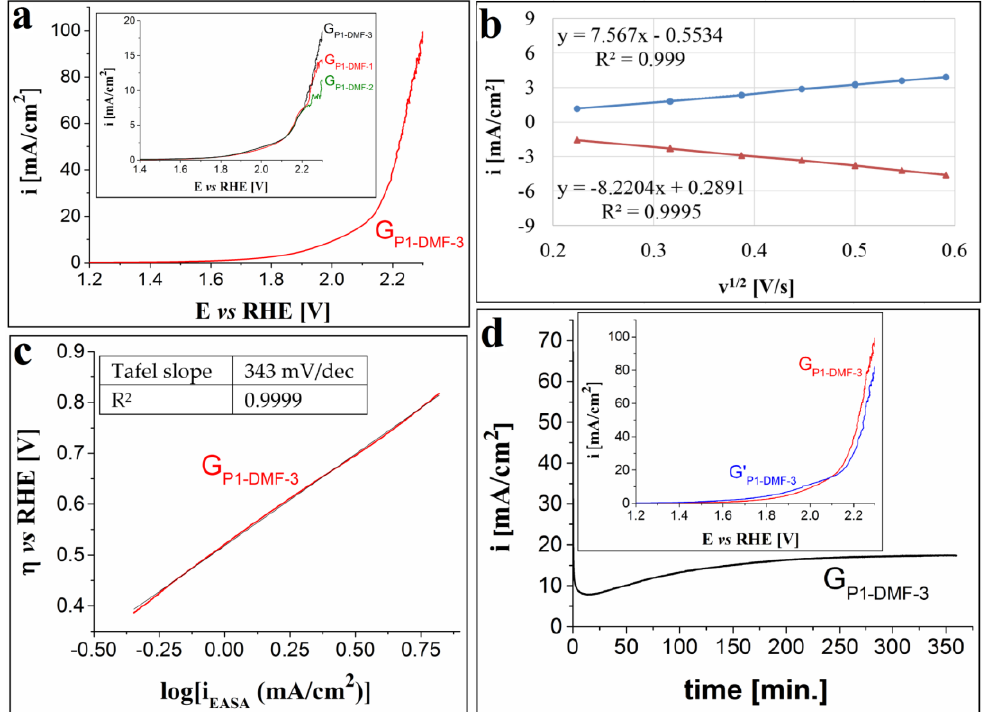
Figure 3. ( a ) Anodic polarization curve traced on the G P1-DMF-3 electrode in 1M KOH solution, at v = 1 mV/s. Inset shows the LSVs recorded on the G P1-DMF-1 , G P1-DMF-2 and G P1-DMF-3 electrodes in 0.1 M KOH solution. ( b ) The plot of the anodic and cathodic peak current densities vs. the square root of the scan rate for the G P1-DMF-3 electrode. ( c ) The Tafel plot for the G P1-DMF-3 electrode in 1 M KOH solution. The current density values (i EASA ) used to represent the Tafel plot were obtained by taking into account the calculated EASA value. ( d ) i-time curve traced on the G P1-DMF-3 electrode in 1 M KOH solution and inset showing the voltammograms recorded on the electrode before and after the stability test (coded as G P1-DMF-3 and G’ P1-DMF-3 ).